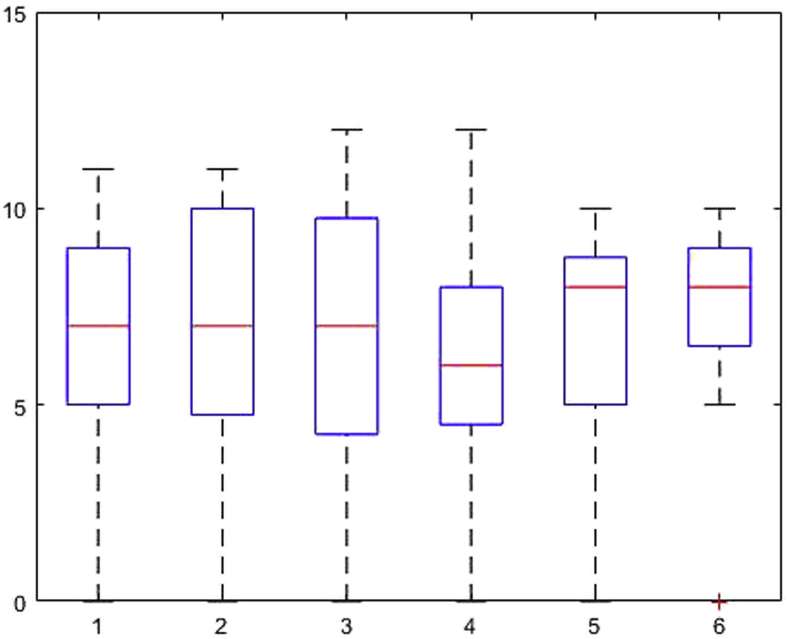
Recognition delayed.